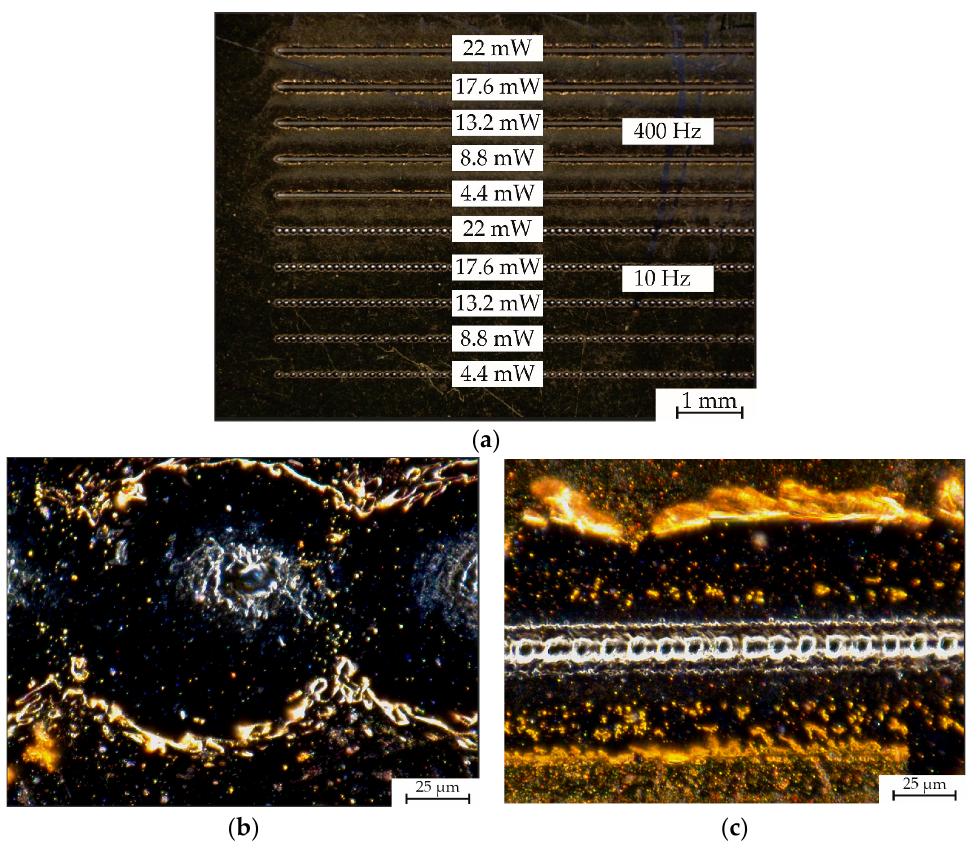
Figure 4. Light microscopy images of the performed experiment with the presence of particles distribution: ( a ) full range of tested laser beam parameters; ( b ) single laser irradiation approach close up; ( c ) 400 Hz approach close up.